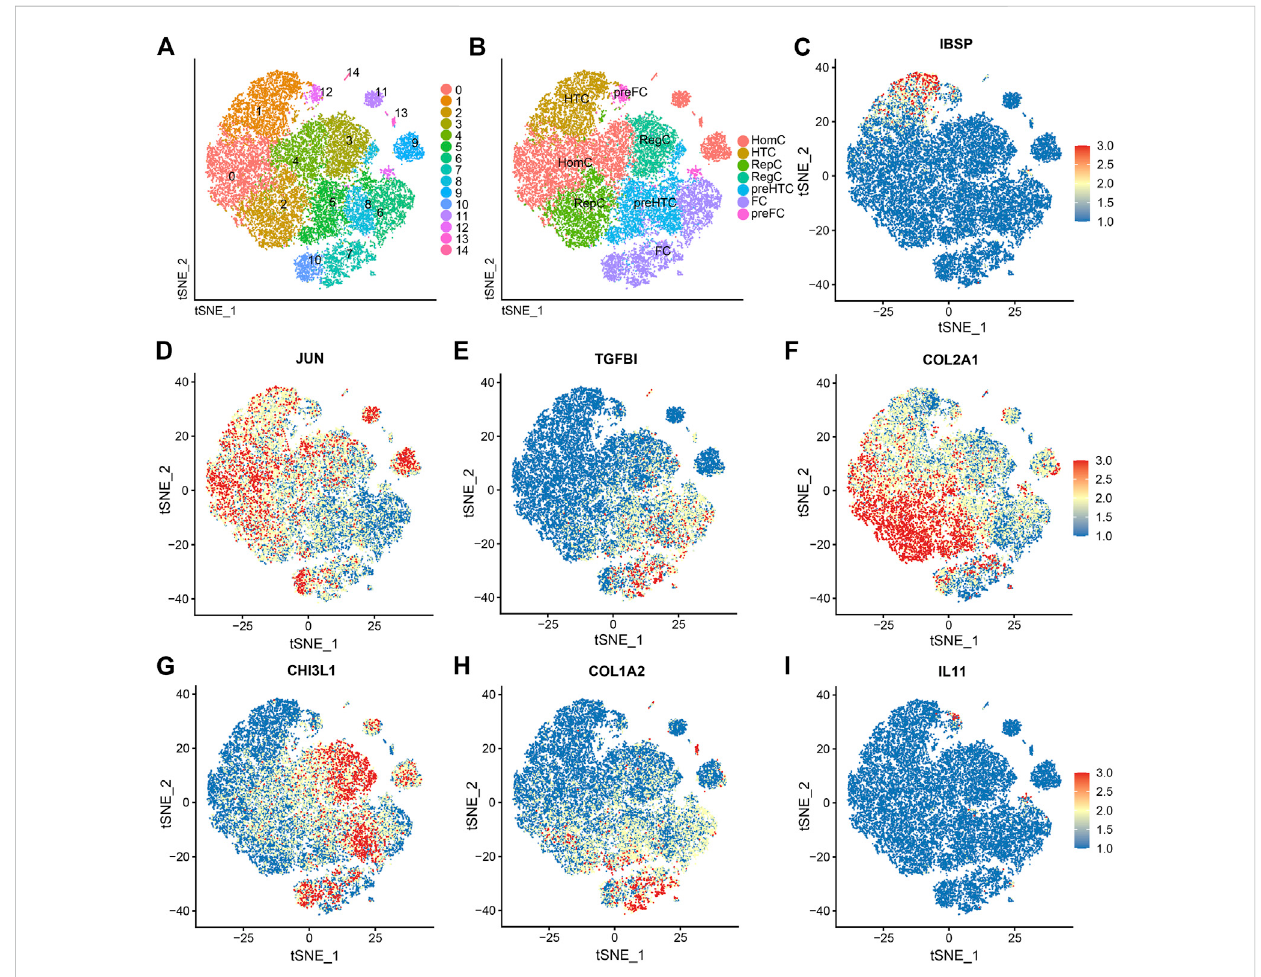
FIGURE 2 Single-cell RNA-sequencing data analysis showing the heterogeneity of chondrocytes. (A) T-distributed stochastic neighbor embedding (t-SNE) plots of identi fi edchondrocyte clusters. (B – I) The seven subtypes of chondrocytes are colored based on the expression of well-known marker genes on the t-SNE map. The color changed from blue to red, indicating a change in gene expression from low to